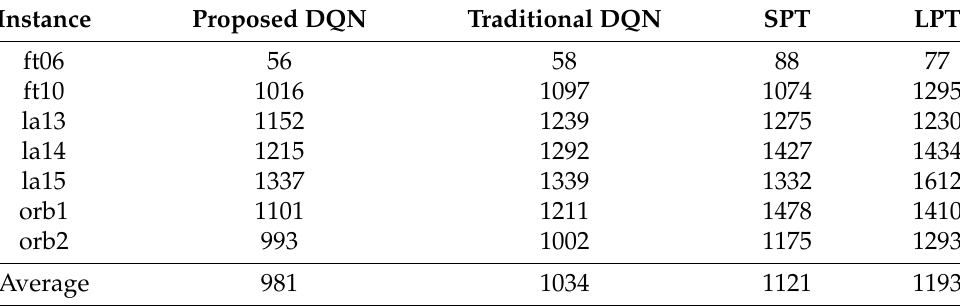
Table 2. Comparison table for the experimental